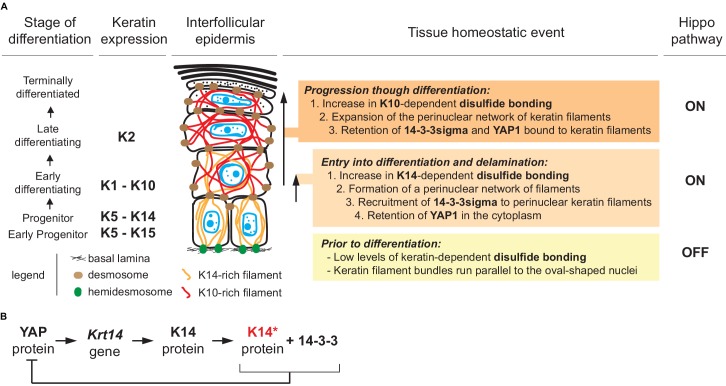
Model depicting the role of keratin-dependent disulfide bonding in integrating signaling and mechanical cues as keratinocytes initiate terminal differentiation in epidermis.(A) Left to right: the stage of epidermal differentiation, keratin expression, epidermal morphology, and state of keratin filament organization are related to 14-3-3 binding, YAP1 subcellular partitioning, and Hippo activity status. The model proposes that initiation of terminal differentiation in late stage progenitor keratinocytes in the basal layer entails: (1) the formation of K14-dependent disulfides via the conserved stutter cysteine in coil two domain; (2) a reorganization of keratin filaments around the nucleus; (3) recruitment of 14-3-3 onto keratin filaments; and (4) effective sequestration of YAP1 in the cytoplasm, resulting in activation of Hippo signaling. The model proposes an identical role for the conserved cysteine in coil 2 of keratin 10, which is expressed early during terminal differentiation, thereby maintaining YAP1’s sequestration to the cytoplasm and active Hippo signaling. These changes are coupled to a redistribution of tension-related forces and cell-cell adhesion complexes as basal keratinocytes delaminate and move from the basal to the suprabasal compartment of epidermis (Miroshnikova et al., 2018; Nekrasova et al., 2018; Wickström and Niessen, 2018). (B) Illustration of a negative feedback loop whereby, once modified in a specific manner (phosphorylation and disulfide bonding), K14 protein sequesters YAP1 and interrupts its activity towards promoting keratinocyte proliferation, thereby initiating terminal differentiation (see Figure 7—figure supplement 1 and 2 for related data).